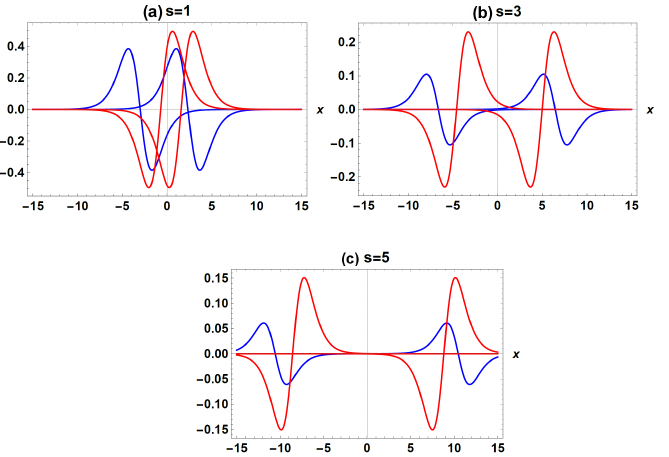
Figure 1. Propagation of the binary waves of θ 1 ( x , y , t ) in (14) Known as ( a ) L-wave. ( b ) R-wave. ( c ) LR-waves.